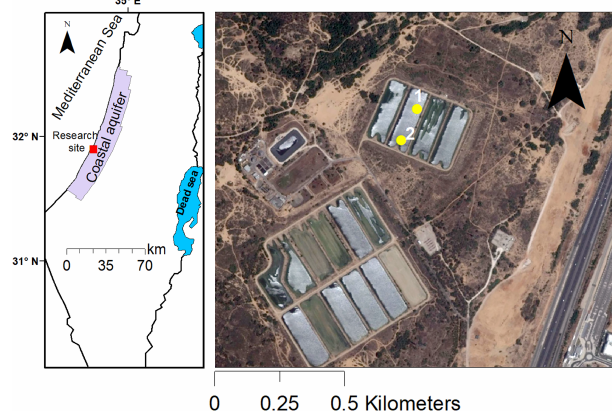
Figure 1. The location of the investigated site – the Yavne 1 infiltra- tion basin of the Shafdan. In the magnified view of the investigated pond, the yellow circles represent the locations of the measurement stations (© Google